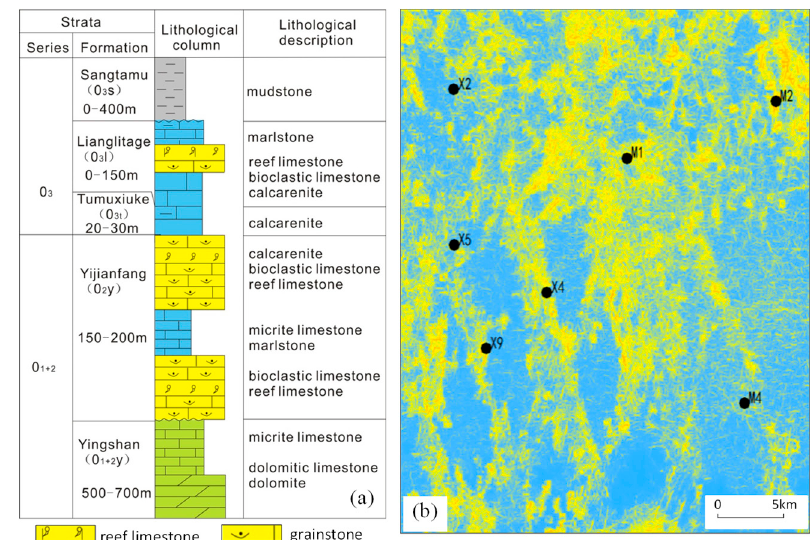
Figure 3. ( a ) Stratigraphic column of the Ordovician carbonate in the Halahatang area, China, and ( b ) Automatic Fault Extraction (AFE) description of the damage zones (yellow areas) affecting the Ordovician carbonate (after [31]) in this area (the black dots show well locations).